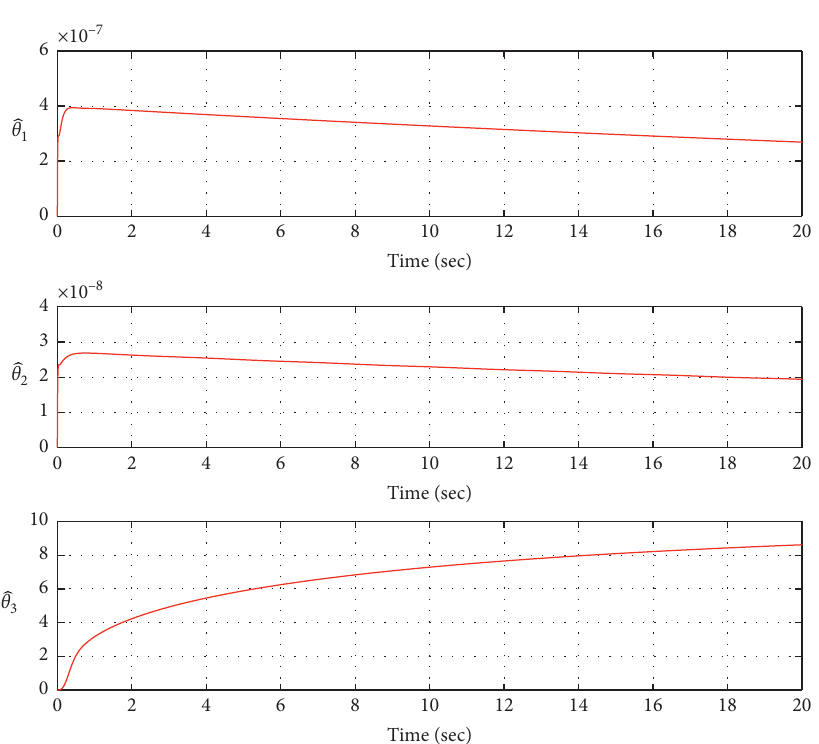
Figure 12: Adaptive parameters 􏽢 θ